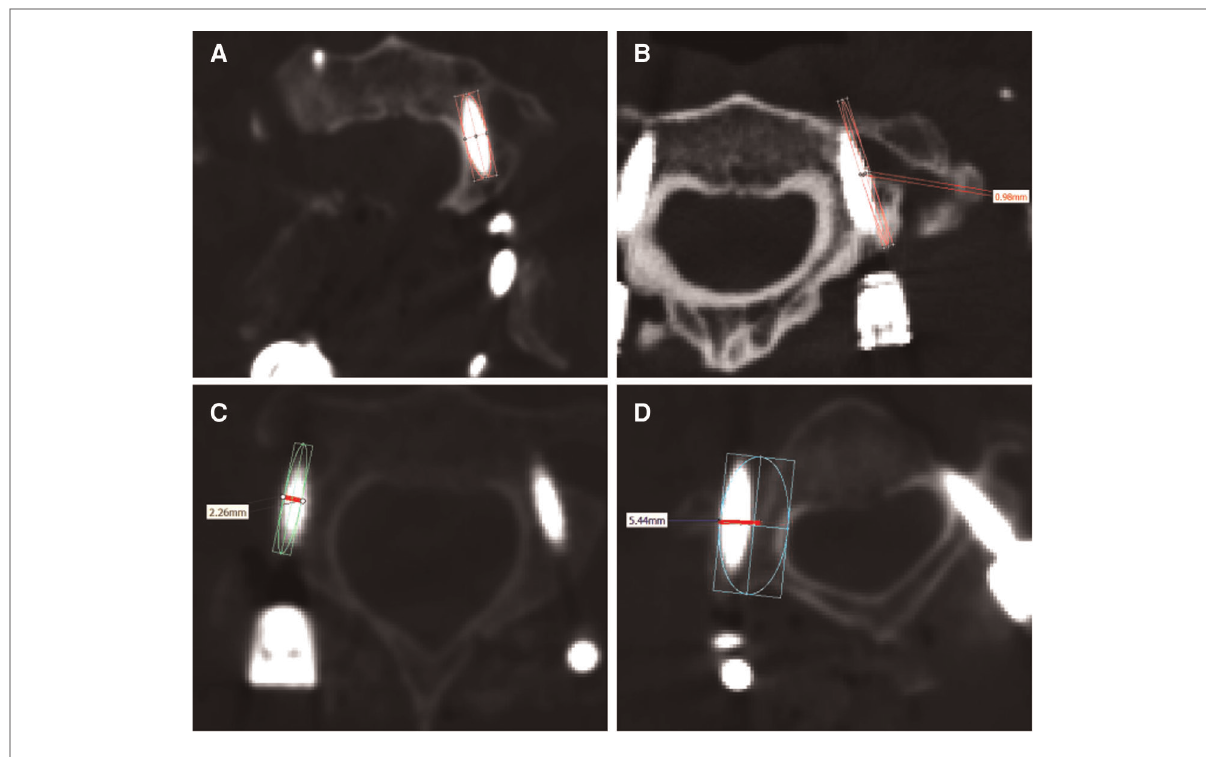
FIGURE 4 ( A – D ) Evaluation criteria for screw implantation quality.